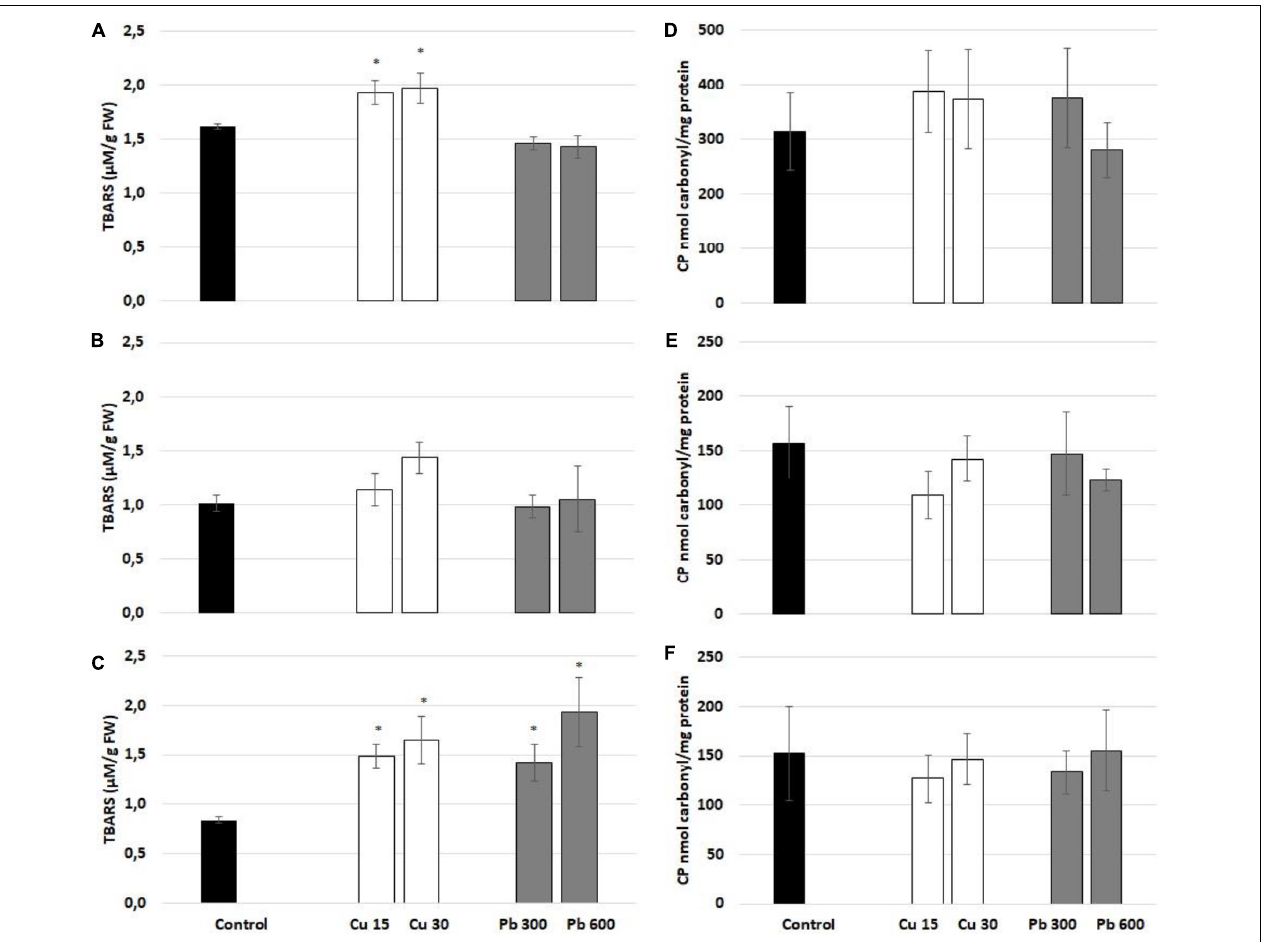
FIGURE 5 | Lipid peroxidation reflected by the level of thiobarbituric acid reactive substances (TBARS) assessed after 1 (A) , 3 (B) , and 24 h (C) and protein carbonylation assessed after 1 (D) , 3 (E) , and 24 h (F) in the roots of control (black bar) soybean seedlings and the roots of soybean seedling exposed to Cu at concentrations 15 and 30 mg/l (white bars) and Pb at concentrations 300 and 600 mg/l (gray bars). The results are means of 4–6 experimental repetitions ± standard error. The statistically significant differences in relation to the control are marked with asterisk